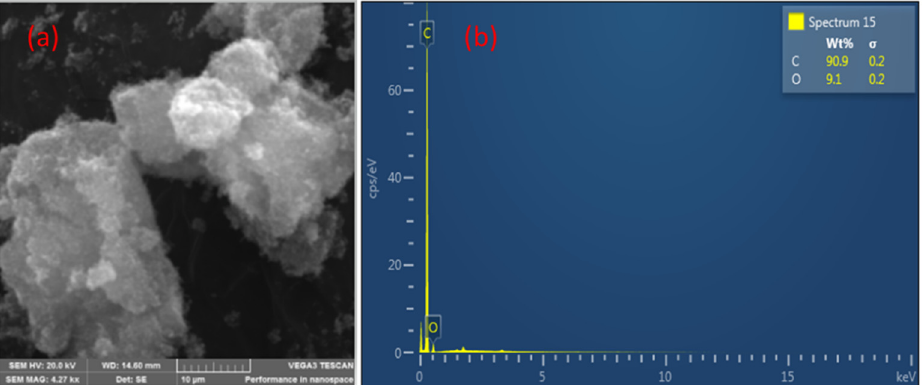
Figure 5. SEM image of ( a ) CNPs and EDS image of CNPs ( b ).